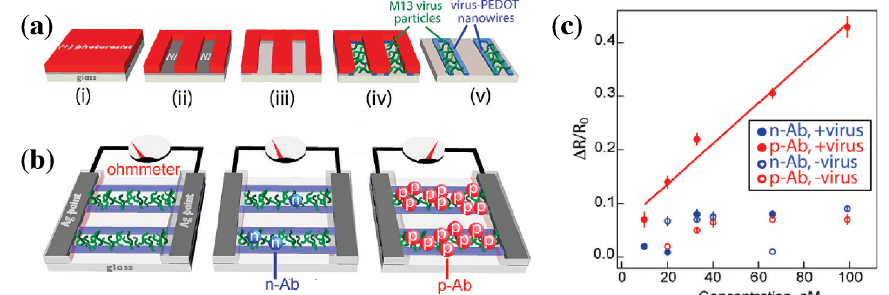
( a ) Illustration of the synthesis of virus-containing PEDOT nanowires through lithographically-patterned nanowire electrodeposition (LPNE). ( b ) Schematic of the resulting nanowires in the final configuration; relatively low ohmic resistance when bare, also after addition of non-binding control antibodies (n-Ab), but significant rise of resistance after applying virus-binding antibodies (p-Ab). ( c ) Resistance changes for combinations of virus containing/free and binding/non-binding antibodies to demonstrate the selectivity. Reprinted with permission from [54]. Copyright 2010 American Chemical